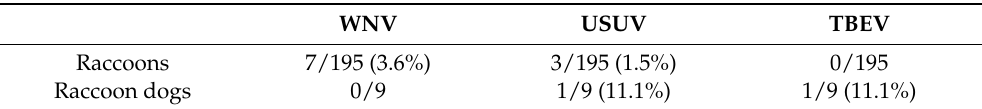
Table 3. Estimation of seroprevalence of WNV, USUV and TBEV by differentiation of antibody reactivity of ELISA-reactive samples in neutralization assays.